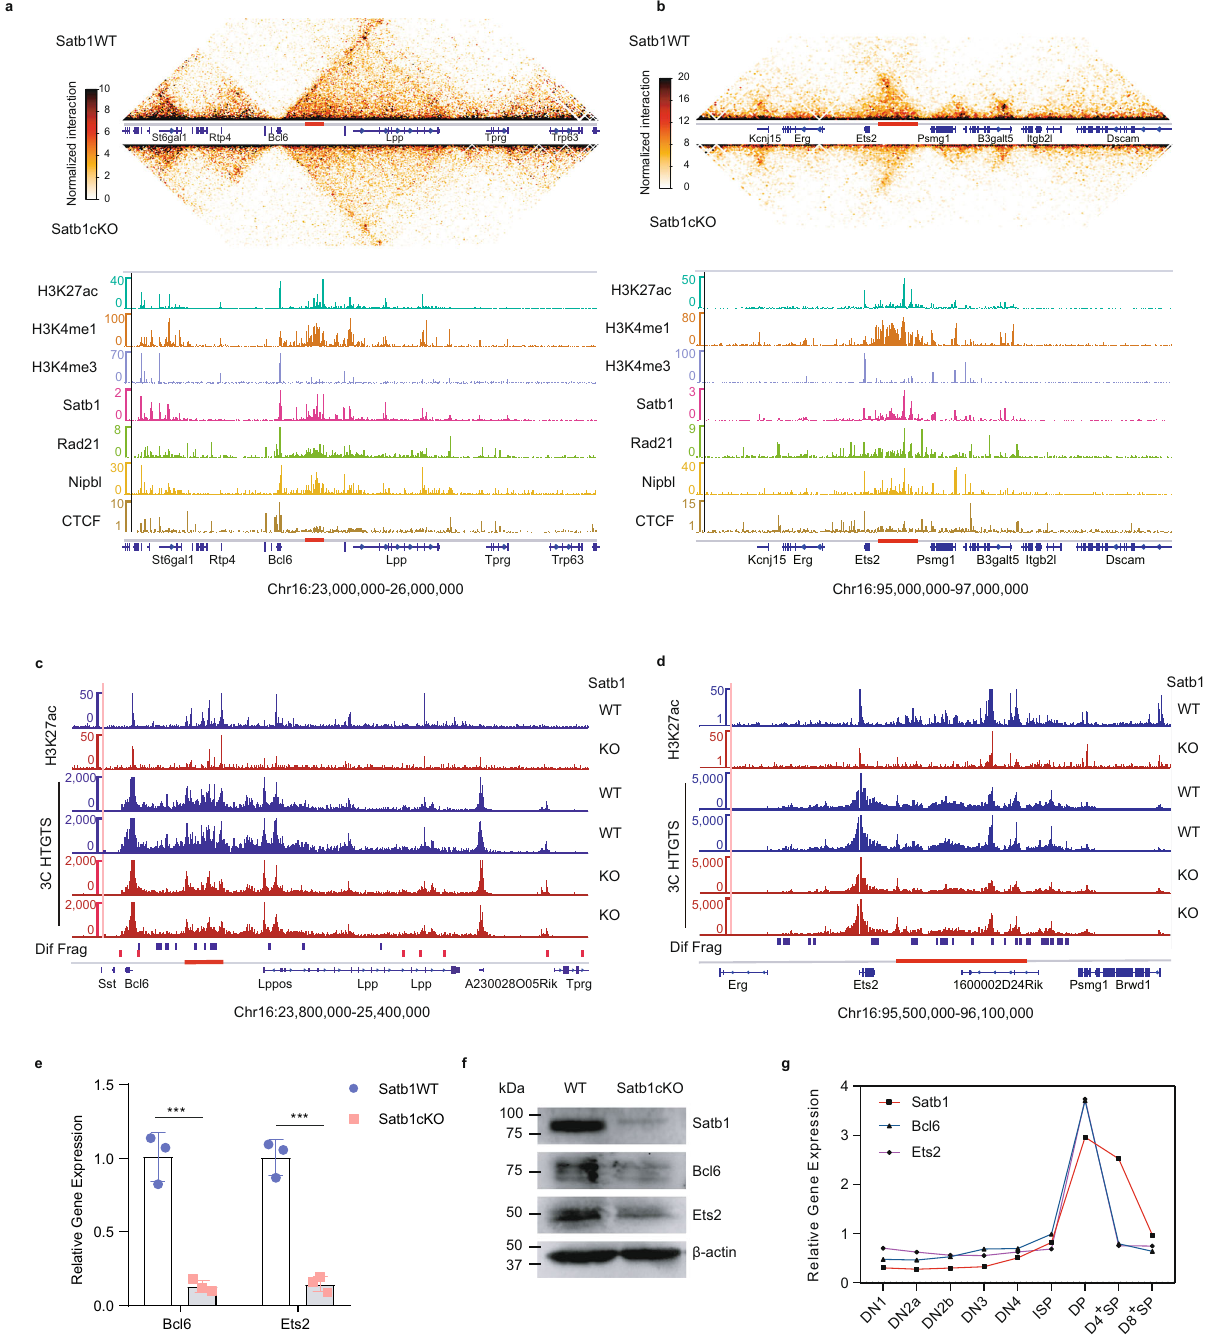
Fig. 5 | SATB1 regulates transcription factors Bcl6 and Ets2 by mediating promoter – enhancer interactions. a , b In situ Hi-C chromatin interaction heat- maps(up)ofSatb1WT andSatb1cKO DP thymocytesfor the Bcl6 ( a ) and Ets2locus ( b ). H3K27ac, H3K4me1, H3K4me3, Satb1, Rad21, Nipbl, and CTCF ChIP-seq tracks (bottom) of Satb1WT cells for each locus. ChIP-seq data are same as Fig. 2c. c , d ChIP-seq and 3C-HTGTS at the Bcl6 and Ets2 loci. The 3C-HTGTS bait is at the Bcl6 or Ets2 promoters. e Relative expression of Bcl6 and Est2 in Satb1WT and Satb1cKO DP thymocytes detected by reverse-transcripted quantitative PCR. The